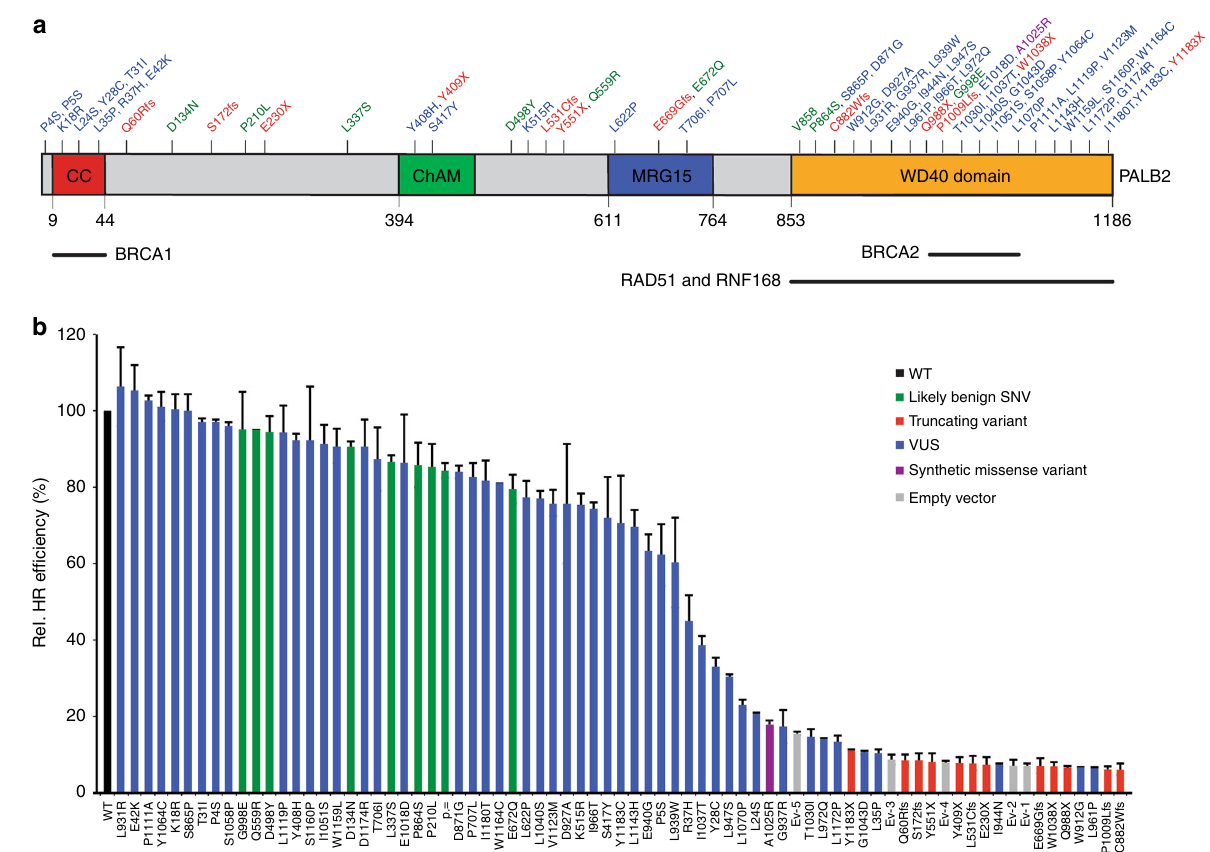
Fig. 2 Human PALB2 variants and their effect on HR. a Schematic representation of the PALB2 protein with variant positions indicated and categorized as either neutral (green), truncating (red), VUS (blue) and synthetic missense variant (purple). The amino acid numbers are shown to specify the evolutionarily conserved functional domains of PALB2. PALB2 regions involved in the interactions with BRCA1, BRCA2, RNF168, and RAD51 are indicated. b DR-GFP assay in Trp53 KO /Palb2 KO mES cells expressing human PALB2 variants (or an empty vector control, Ev). Cells were transfected with an I-SceI and mCherry co-expression vector. GFP expression was monitored by FACS. Data represent mean percentages (±SEM) of GFP-positive cells among the mCherry-positive cells relative to wild type (WT), which was set to 100%, from two independent experiments, except for p.L939W and p.G998E for which data from three independent experiments are presented. Variants/conditions are categorized by color as either wild type (WT, black), likely benign SNV (green), truncating variant (red), VUS (blue), synthetic missense variant (purple) or empty vector (Ev, gray). Ev1 – 5 refer to Ev controls from 5 different replicates. Source data are provided as a Source Data fi